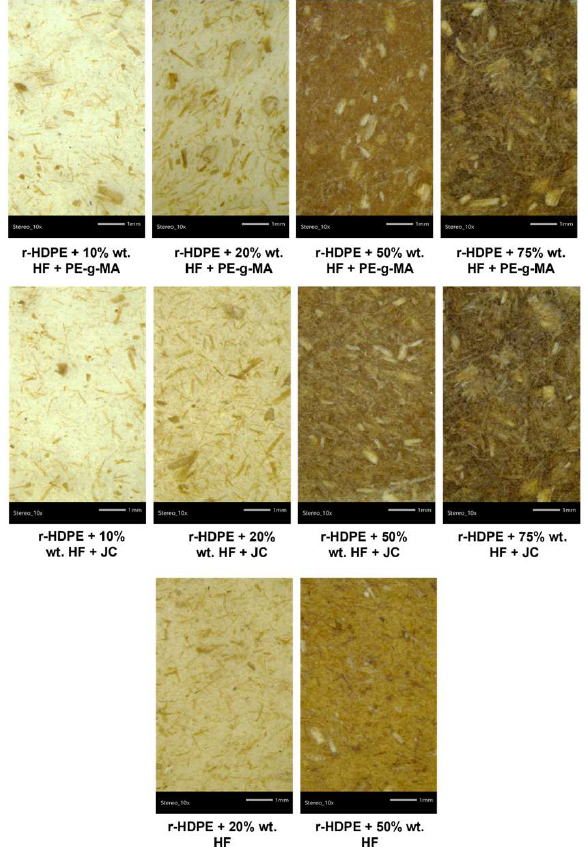
Figure 2. Stereoscopic microscope images for the recycled high-density polyethylene (r-HDPE) + hemp fibers (HF) composite materials.